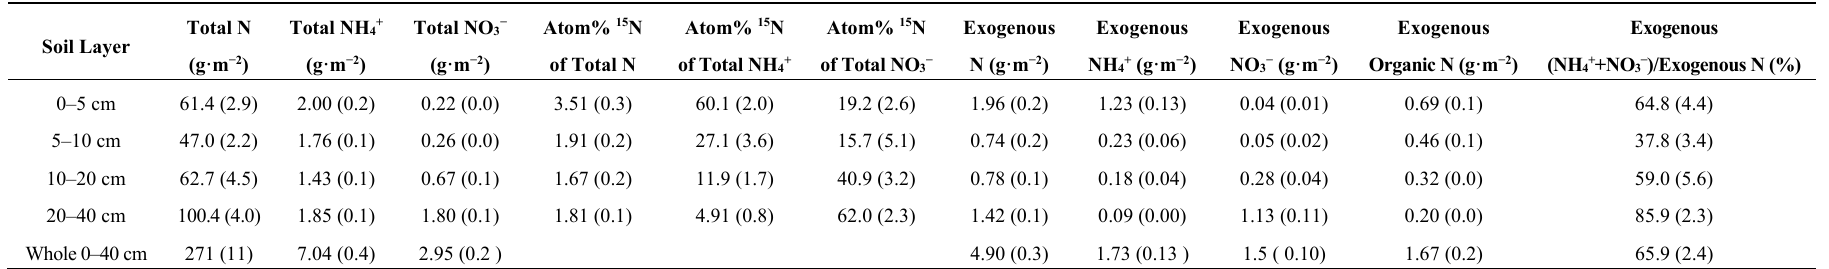
Table 2. Contents and 15 N abundances in soil N pools of the N addition treatment three months after N addition (mean ± standard error (se); n = 8).